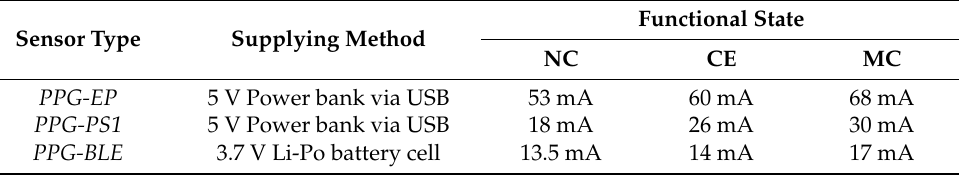
Table 3. Comparison of PPG sensors’ mean DC values for three functional states and used power